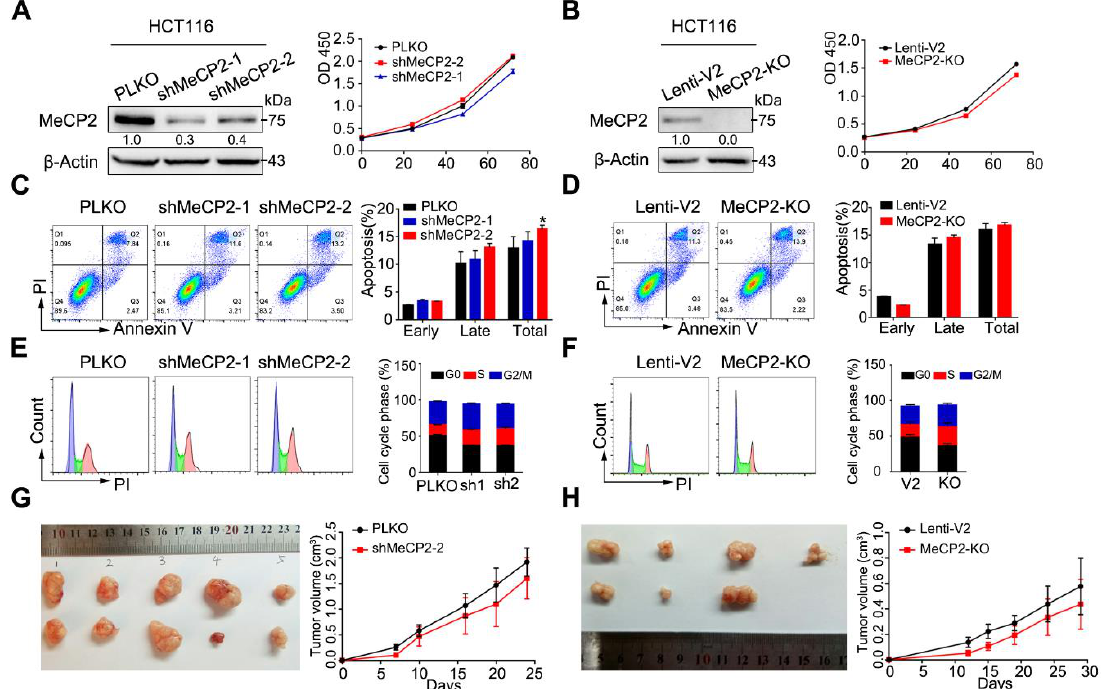
Figure 2. MeCP2 depletion does not influence the proliferation of colorectal cancer (CRC) cells in vitro and in vivo. ( A ) shRNA-mediated MeCP2 knockdown was determined by Western blot (left). MeCP2 silencing did not influence cell viability in HCT116 cells (right). ( B ) sgRNA-mediated MeCP2 knockout was determined by Western blot (left). MeCP2 knockout did not influence cell viability in HCT116 cells (right). ( C ) MeCP2 knockdown did not a ff ect apoptosis of HCT116 cells. ( D ) MeCP2 knockout did not influence apoptosis in HCT116 cells. ( E ) MeCP2 knockdown did not influence the cell cycle distribution. ( F ) MeCP2 knockout did not a ff ect cell cycle distribution. ( G ) MeCP2 knockdown did not suppress cell proliferation in vivo. ( H ) MeCP2 knockout did not influence cell proliferation in vivo.